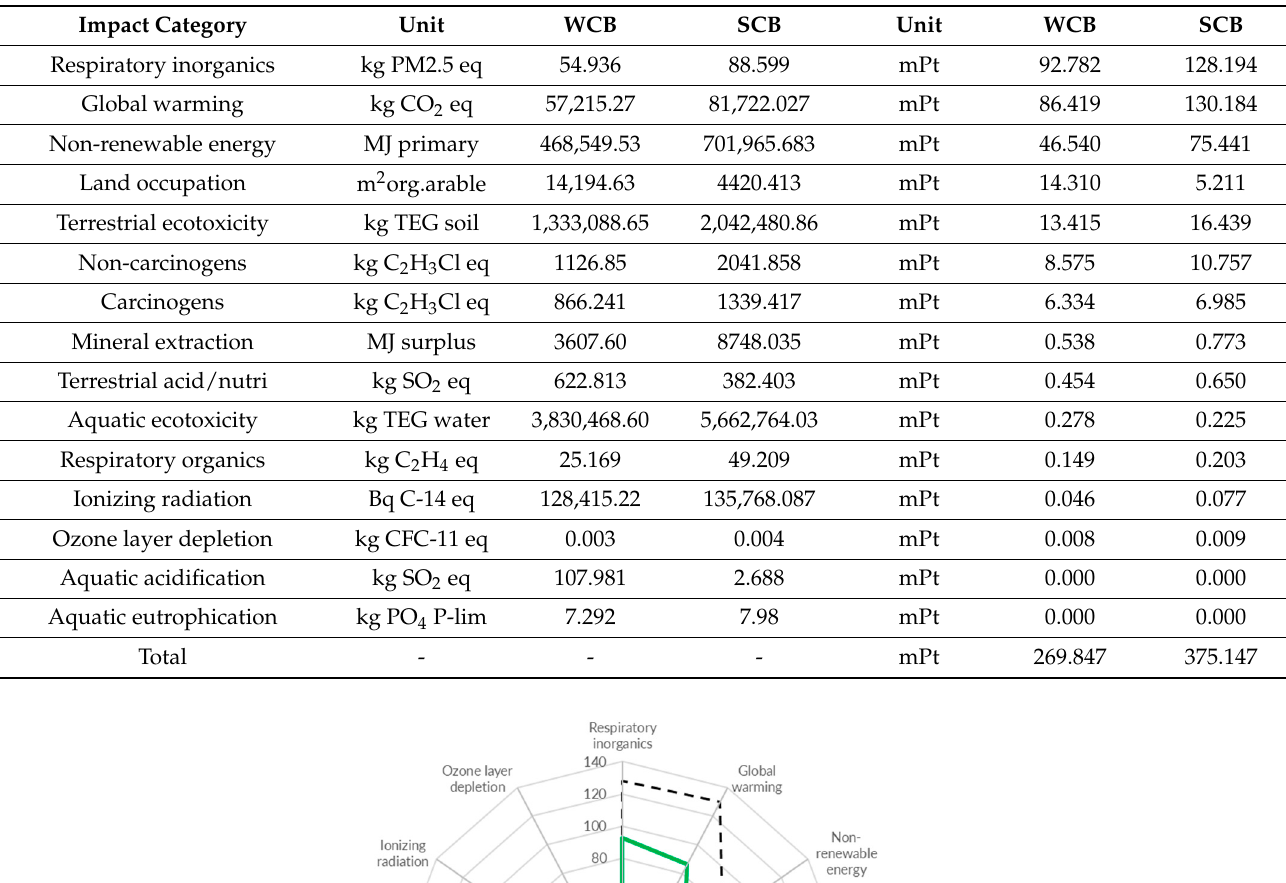
Table 4. Characterization and environmental damage of WCB and SCB per m 2 (SimaPro, IMPACT 2002+, midpoint categories).